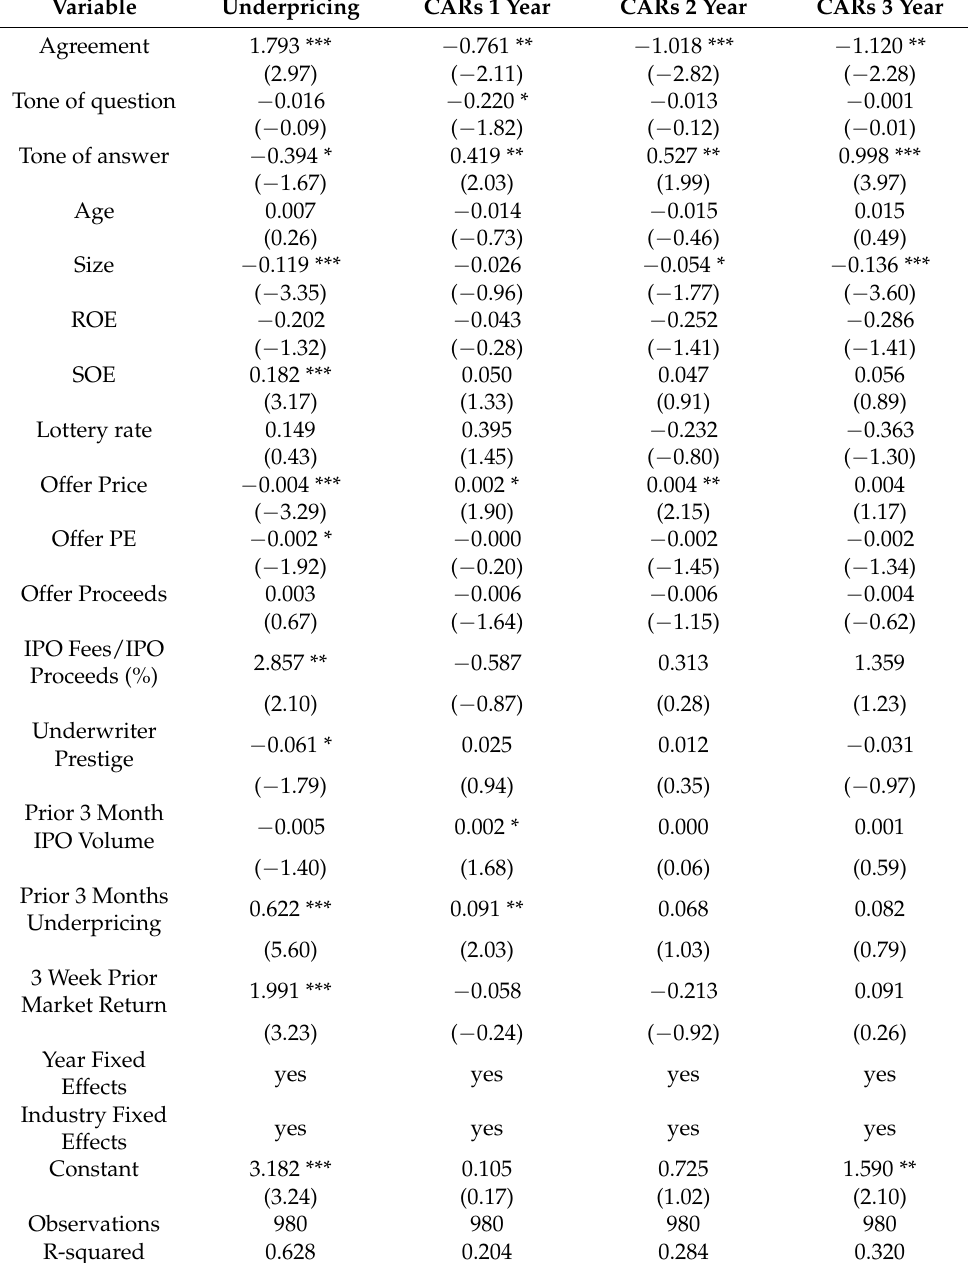
Table 7. Robustness Check: Industry-adjusted